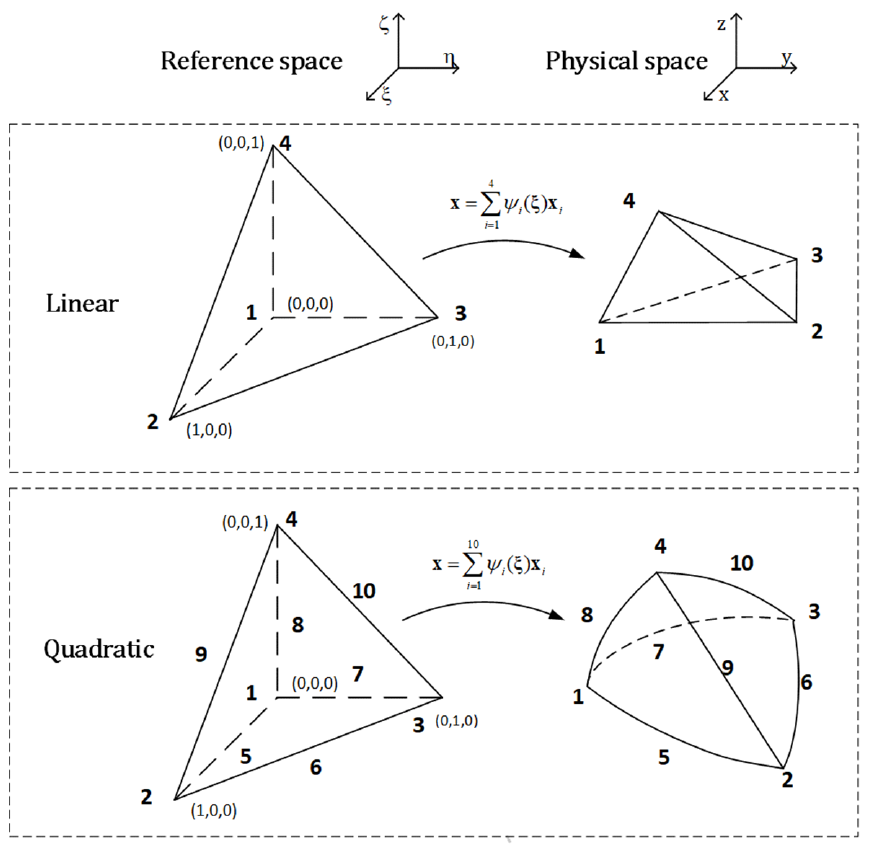
Figure 1. Tetrahedron element in reference space ( left ) and physical space ( right ). The bold integer numbers are the indexes of the corresponding mapping points.